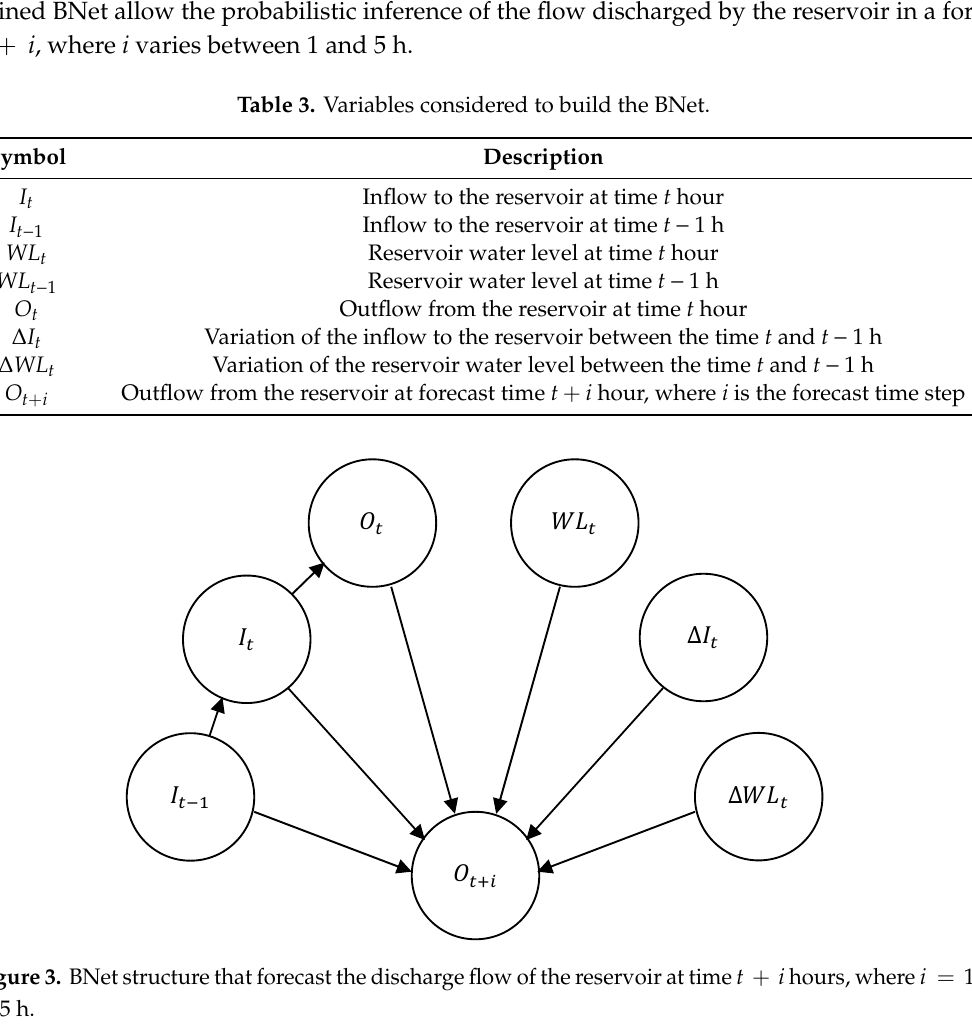
Table 3. Variables considered to build the BNet.